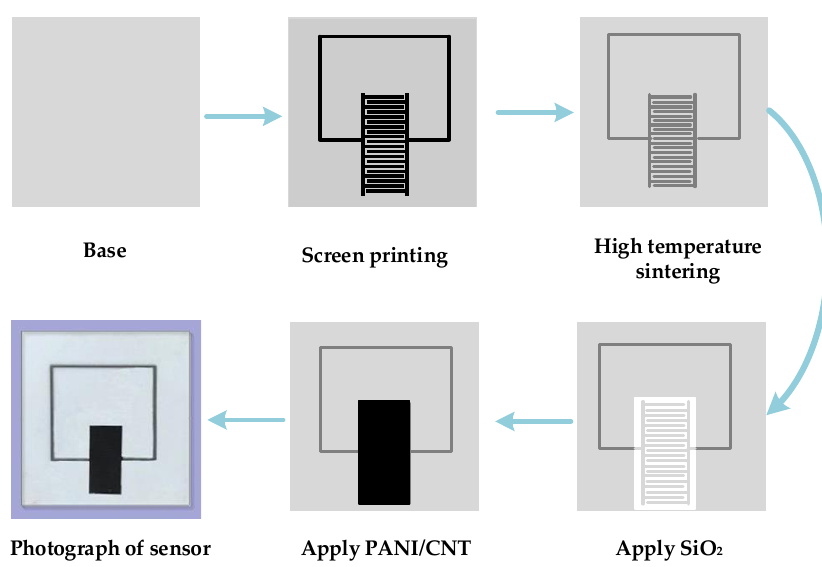
Figure 7. Process of sensor preparation.